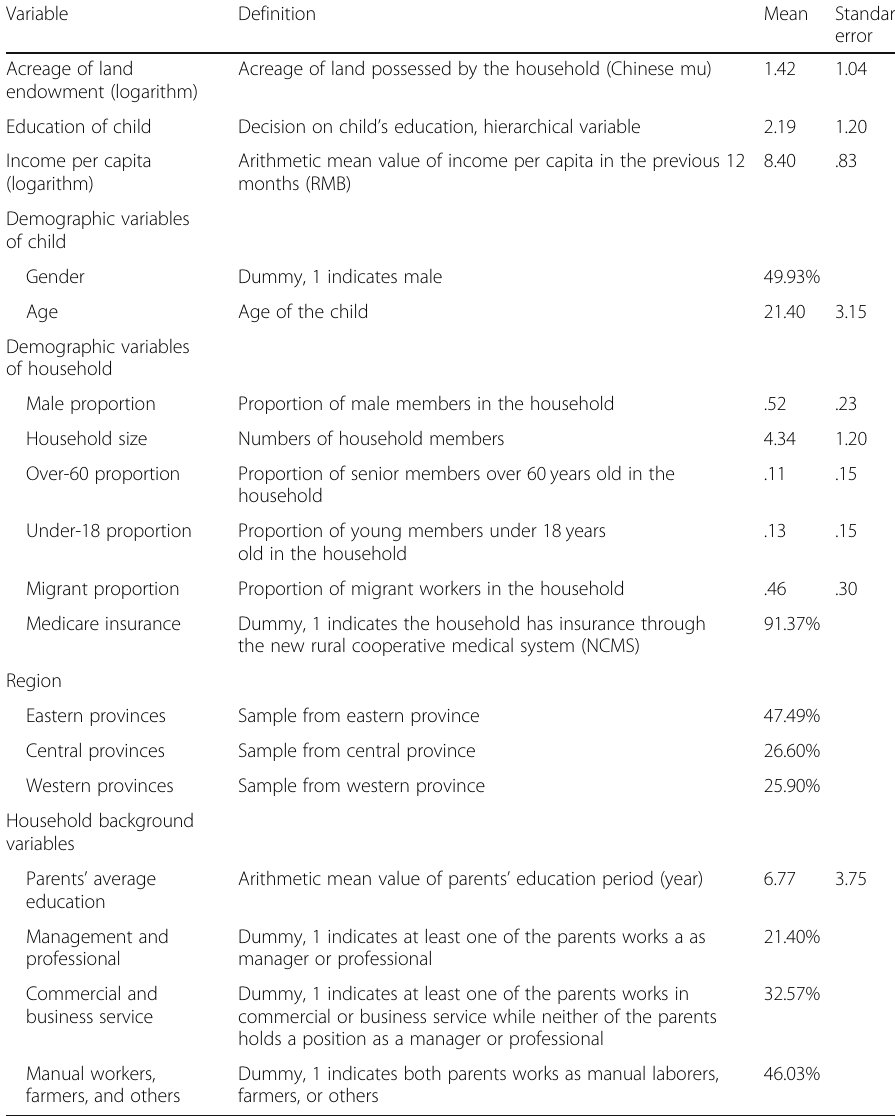
Table 1 Variable definition and descriptive